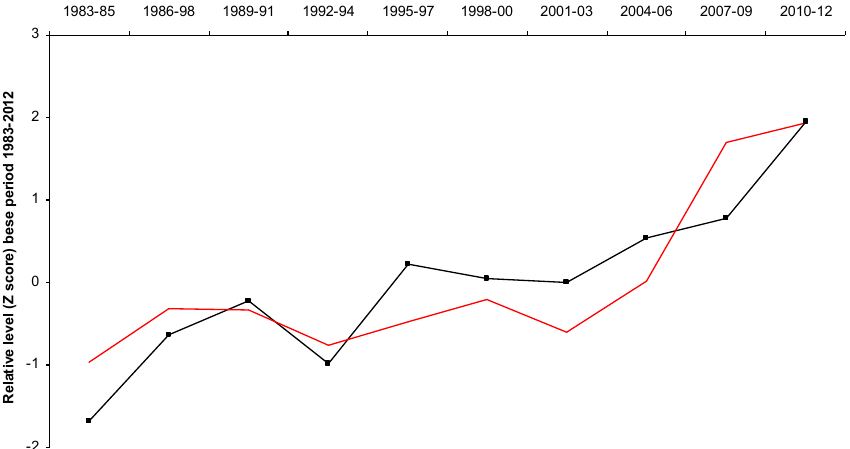
Figure 12. Z -scored data for periods each of 36 months, averaged: NDVI (black curve) compared to the difference between the temperature projected from an IPCC mid-range scenario model (CMIP3, SRESA1B scenario) run for the IPPC fourth assessment report (IPCC, 2007) and global surface temperature (red dotted